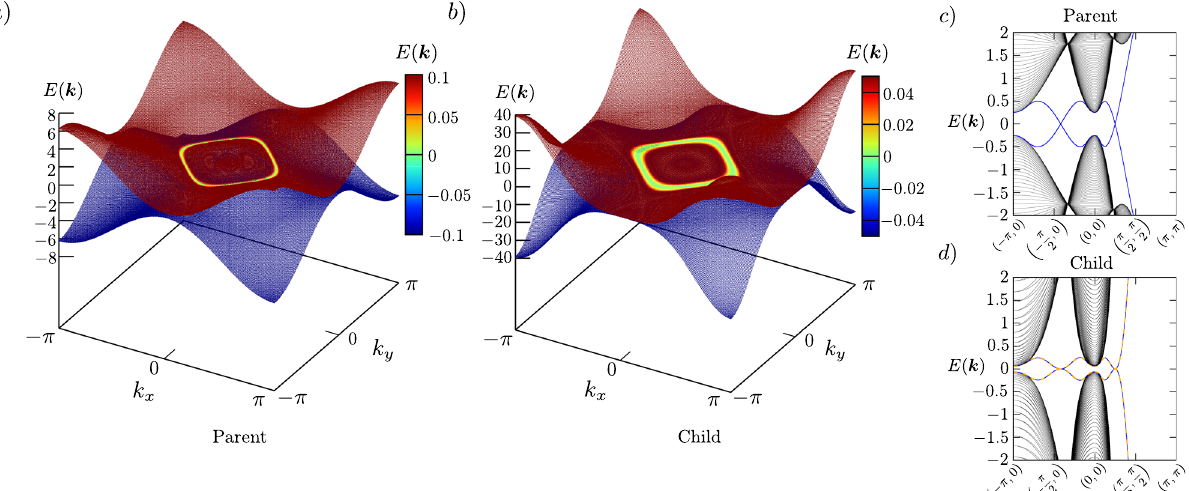
Fig. 3 Comparison of bulk-boundary correspondence for parent topological phase with that of the child topological phase. a The two middle bands of the surface spectrum for a Hopf insulator slab with open boundary conditions in the {001} direction for m = 1.5, showing the distinctive Fermi ring of topologically protected gapless boundary states, and b the four middle bands of the surface spectrum for a multiplicative Hopf insulator slab with open boundary conditions in the {001} direction for m = 1.5, showing a double-degenerate Fermi ring of topologically protected gapless boundary states. The number of layers in each slab calculations is N = 80, and the step size in k -space is 0.02. The energy scales in a and b are highlighted by color ranging from blue to red. c The full slab spectrum for the Hopf insulator along high-symmetry lines with open boundary conditions in the {001} direction, with topologically protected gapless boundary states of the two middle bands in energy highlighted in dark blue. d the full slab spectrum for the multiplicative Hopf insulator along high-symmetry lines with open boundary conditions in the {001} direction, with topologically protected gapless boundary states of the four middle bands highlighted as dashed blue and orange lines. Each dashed blue and orange line is doubly degenerate. The number of layers in each slab calculations is N = 80, and the step size in k -space is